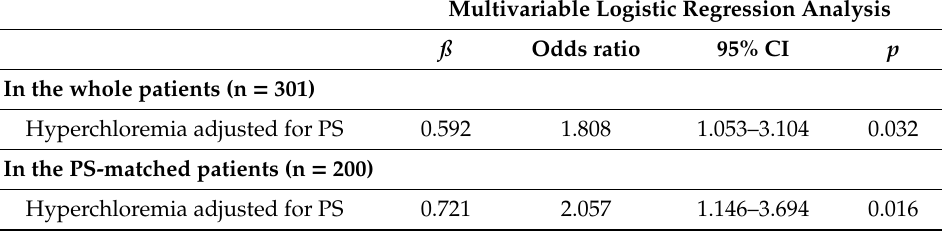
Table 6. Association of hyperchloremia with poor early graft function (eGFR < 60 ml / min / 1.73 m 2 ) on postoperative day 2 in living donor kidney transplantation. Multivariable Logistic Regression